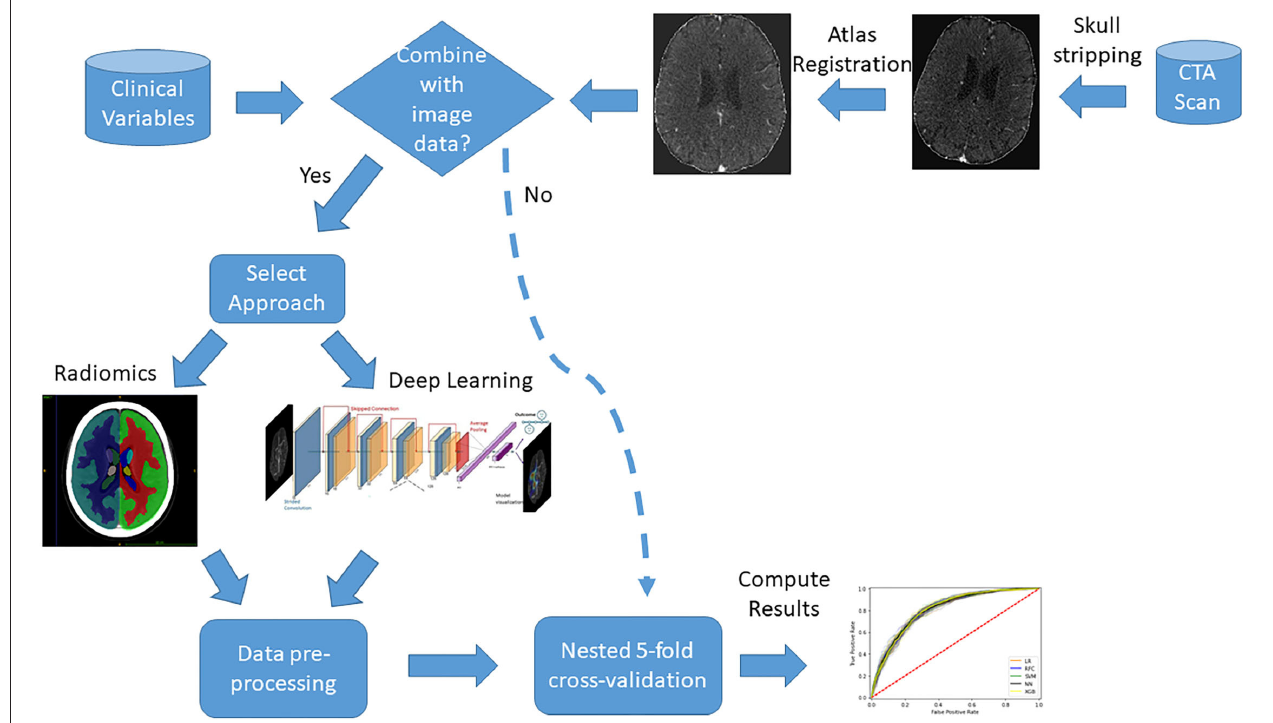
FIGURE 1 | Diagram with an overview of the main data pre-processing steps and combination